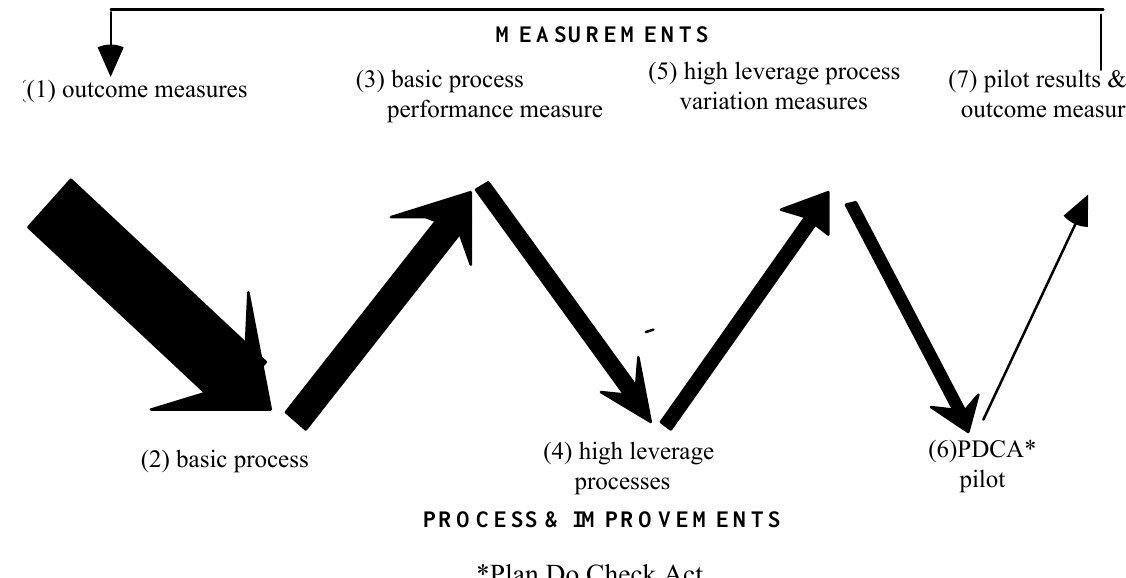
Figure 2. Diagrammatic Model of the 'Serial V' Concept in Continuous Quality